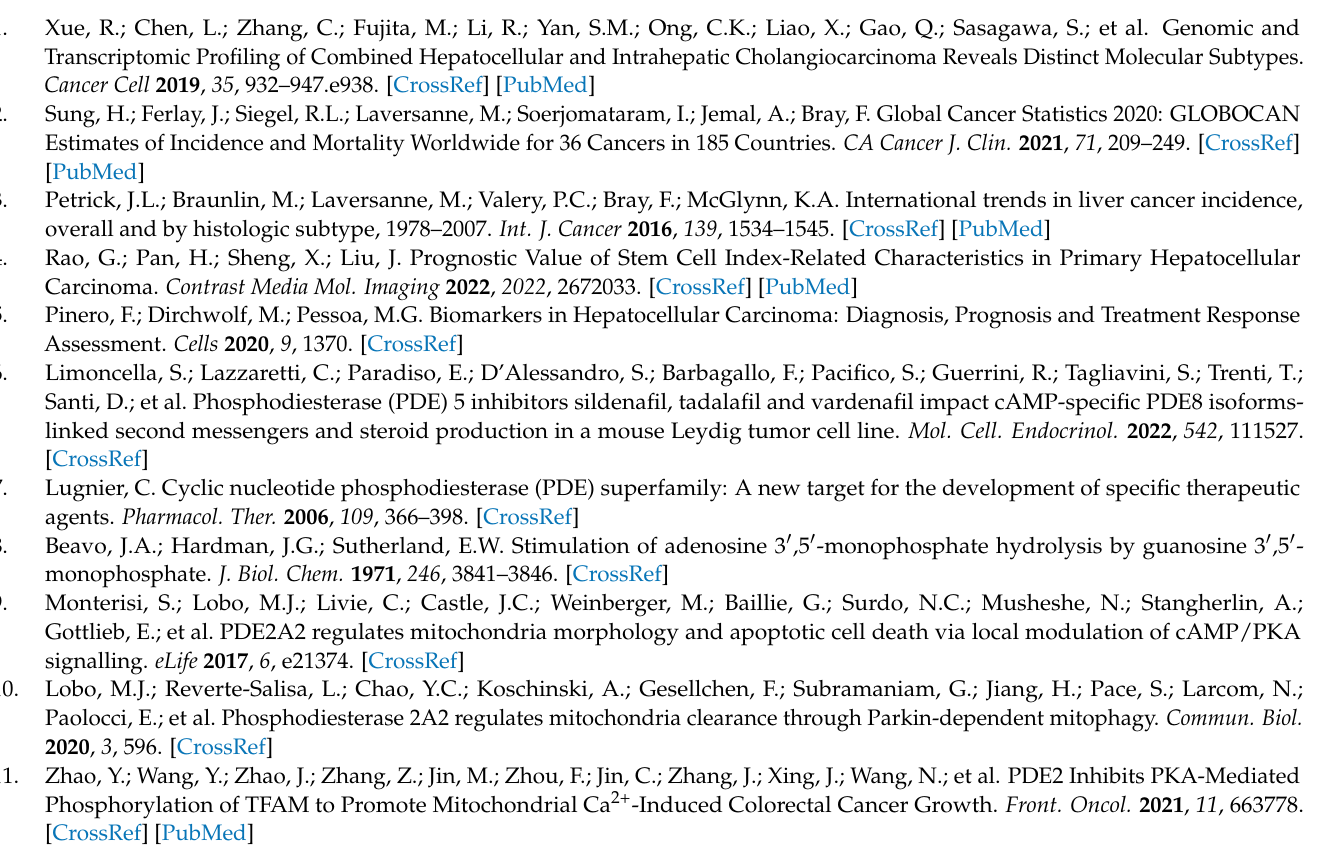
outcomes in HCC patients. Figure S1. Related to Figure 2. Gene Set Enrichment Analysis (GSEA) of differentially expressed mRNAs between high- and low-PDE2A expression groups except for the representative figures showed in Figure 2. Figure S2. Receiver operating characteristic